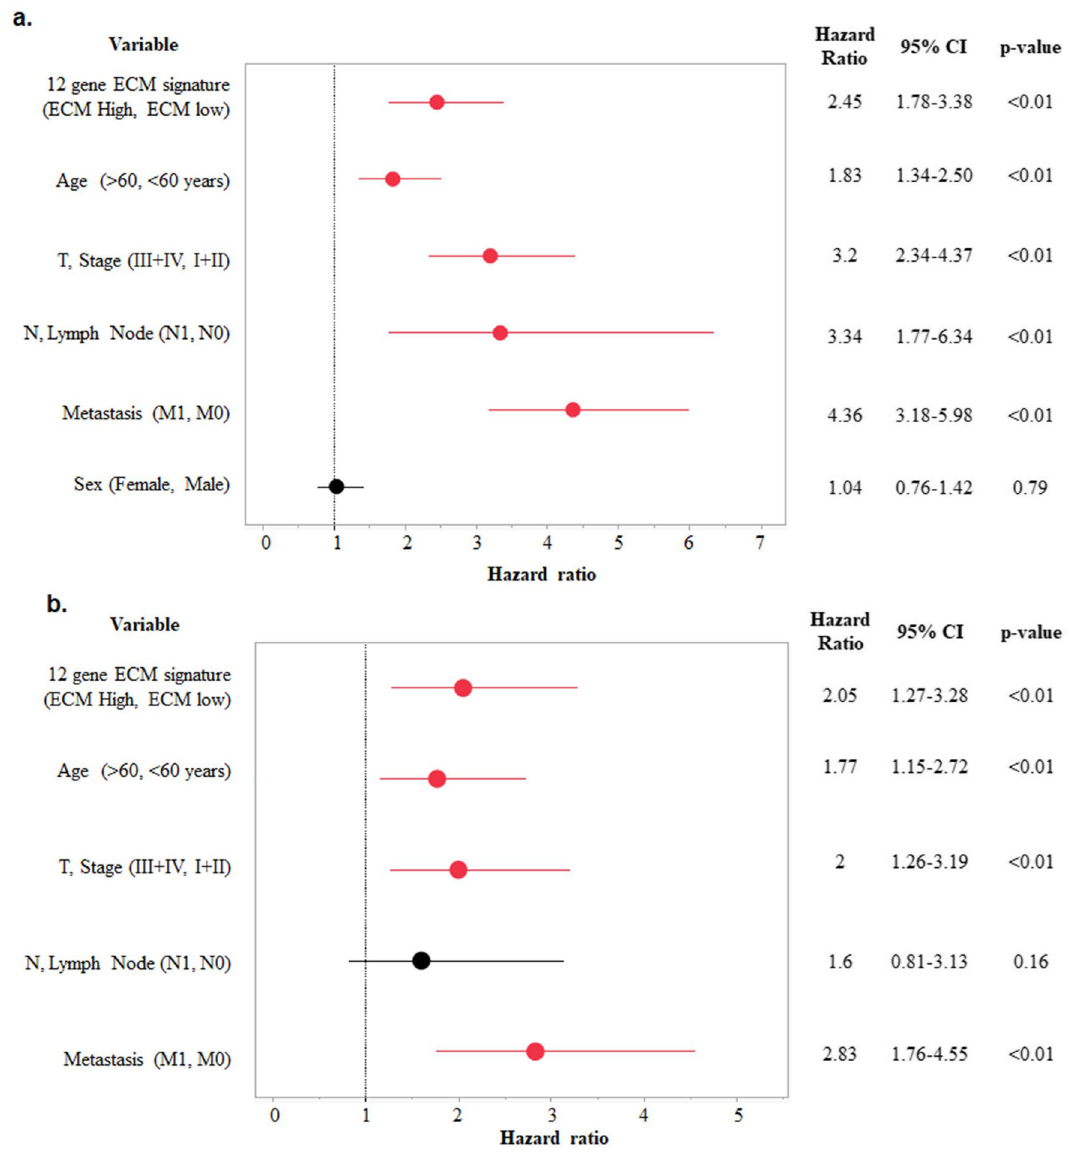
Figure 4. ( a ) Univariate and ( b ) Multivariate cox regression analysis of 12 gene ECM signature with age, Stage, N, Metastasis, and